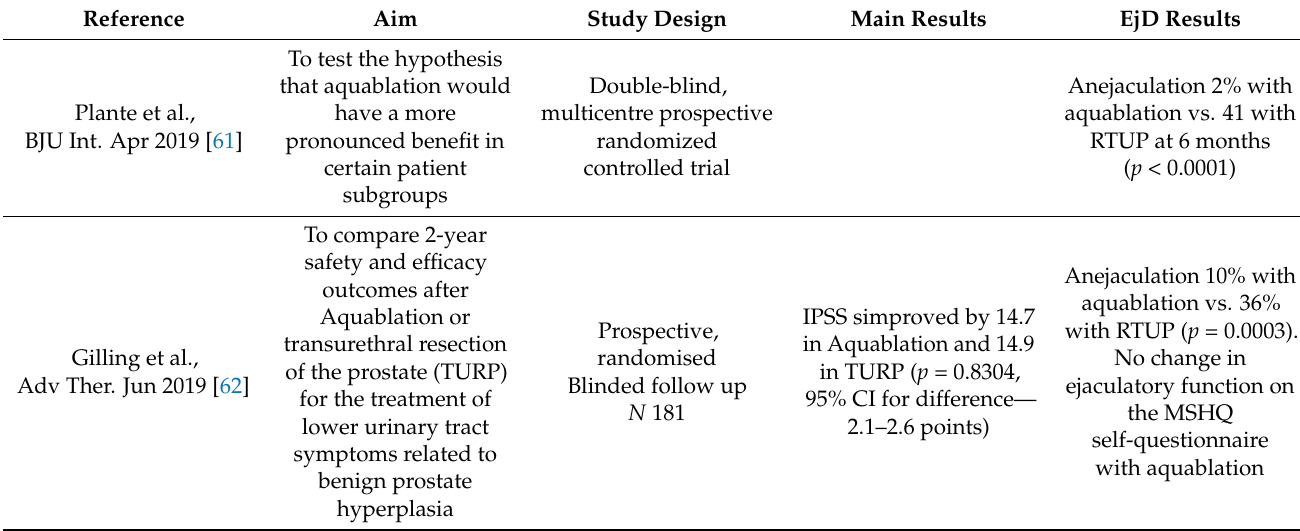
Table 11. Impact of Aquablation procedure on the ejaculatory